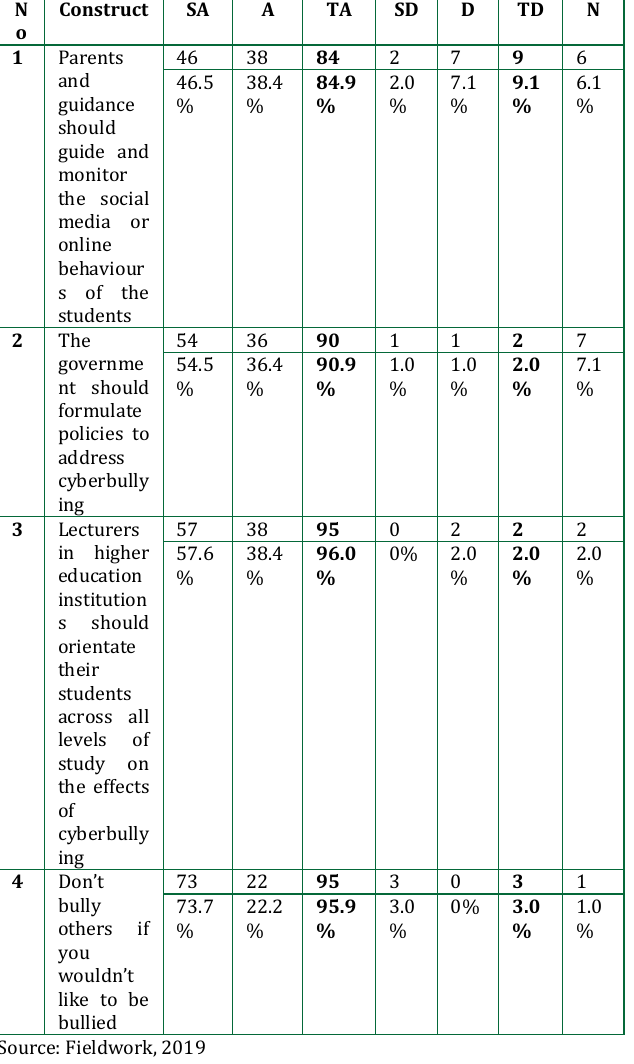
Table 12: Parents and guidance, government policies, lecturer and don’t bully other s